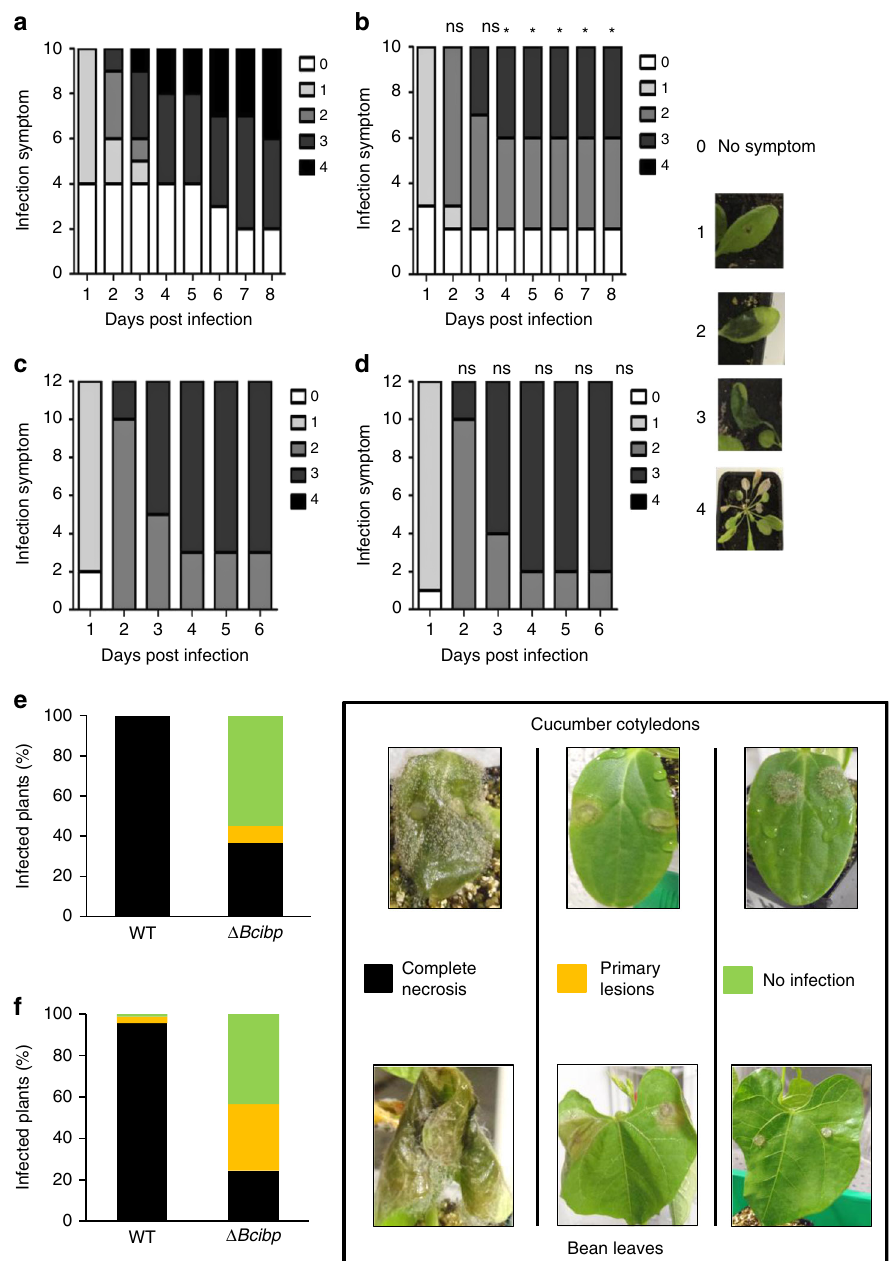
Fig. 9 Reduced virulence of D. dadantii and B. cinerea ibp mutants. a – d Evolution of the symptoms on A. thaliana Col0 ( a , b ) and atrbohD-atrbohF ( c , d ) after inoculation with the wild type ( a , c ) or the ibpS mutant strain ( b , d ). Infection was performed on a single leaf by the deposition of a drop containing ~ 50 bacteria on a wound made by a needle. Symptoms were classi fi ed in fi ve stages as shown on the right. Stage 0: no symptoms; stage 1, symptoms around the spot of infection: stage 2: maceration of the leaf limb; stage 3: maceration of the whole leaf, including the petiole; stage 4: generalization to the whole plant. * indicates a statistical difference ( p < 0.05) between results of the wild type and the mutant strain at a given day (Khi2 likelihood ratio test). ns: not signi fi cant. No difference in class distribution was observed for the atrbohD-atrbohF mutant infection. One representative experiment out of four (for the Col0 infection) and out of three (for the atrbohD-atrbohF mutant infection) is represented. e , f Pathogenicity assays of the B. cinerea wild-type strain and Δ Bcibp strains on cucumber cotyledons ( e ) and French bean leaves ( f ). Seven-day-old plants were infected with 3-day-old mycelial plugs. Disease symptoms were scored 6 days after infection. The disease categories and symptom developments on both plant hosts are indicated on the right. All tests were performed in three independent experiments with at least fi fteen leaves or cotyledons per strain for each test and two points of infection per leaf